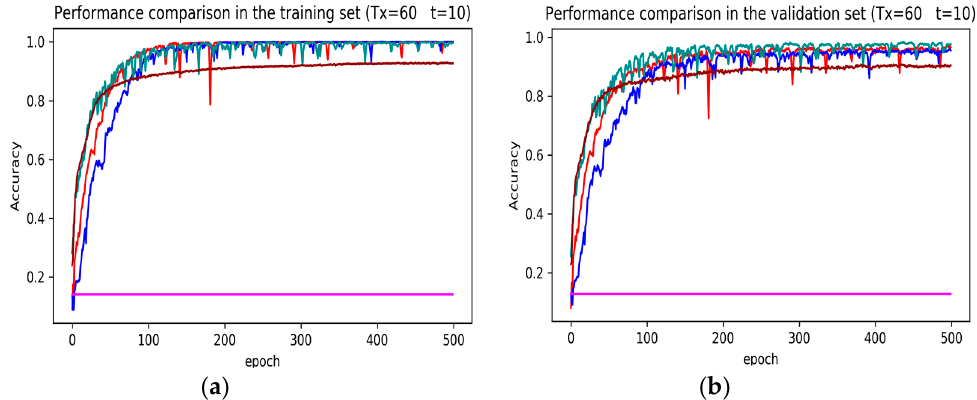
Figure 11 . Performance comparison of different models in accuracy using original 51D features when setting T x to 60 samples and ∆ t to 10 samples. ( a ) Performance comparison in the training stage. ( b ) Performance comparison in the validation stage. Here, the attention-based DeepConvGRU and DeepConvLSTM performed better than DNN using statistical 45D features.